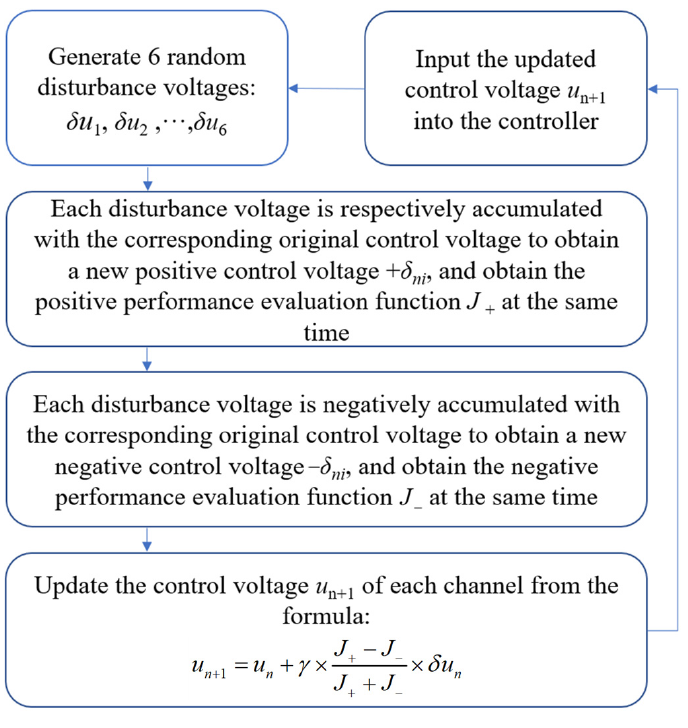
Figure 1. Control loop of SPGD algorithm.